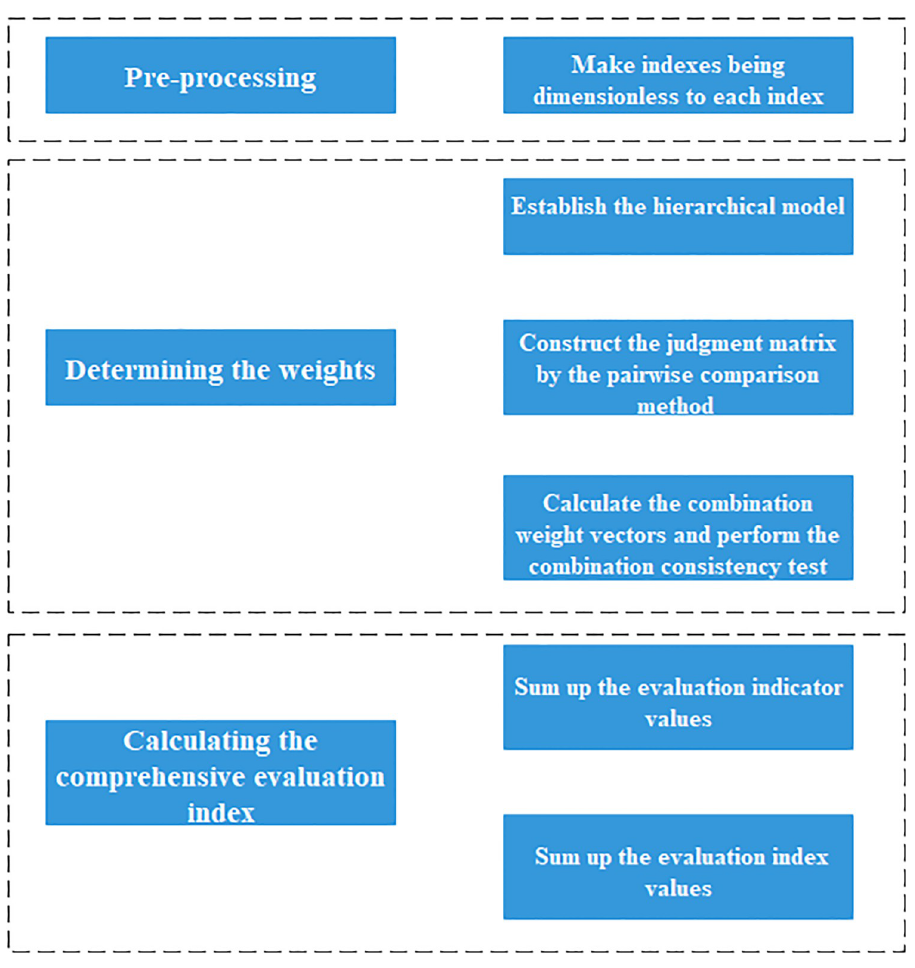
Fig 1. The workflow of evaluation